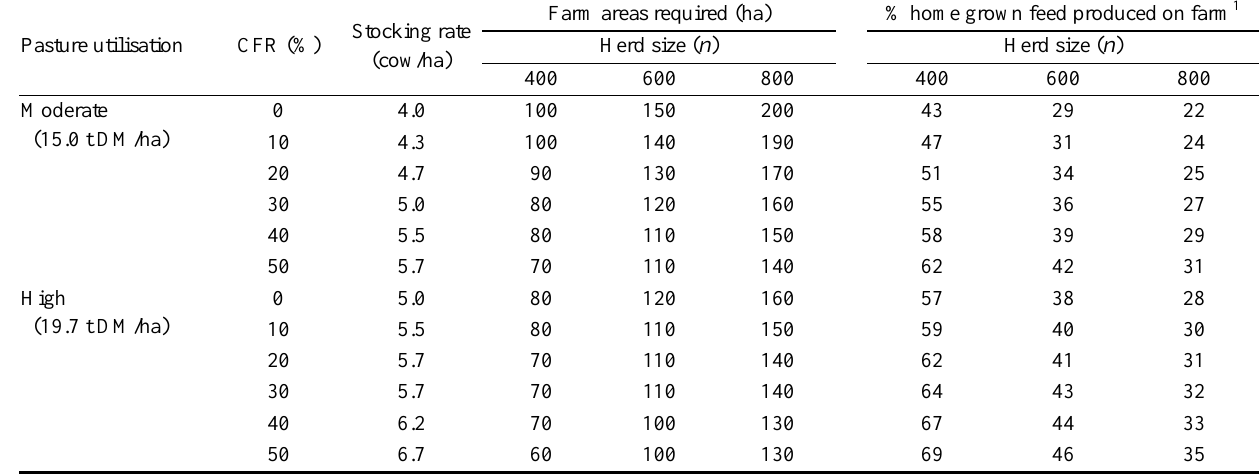
Table 4. Farm areas and stocking rate of cows required for different herd sizes managed in moderate and high pasture utilisation system with different rates of grazeable complementary forage rotation (CFR) in automatic milking system Farm areas required Stocking rate Pasture utilisation CFR (%) (cow/ha)